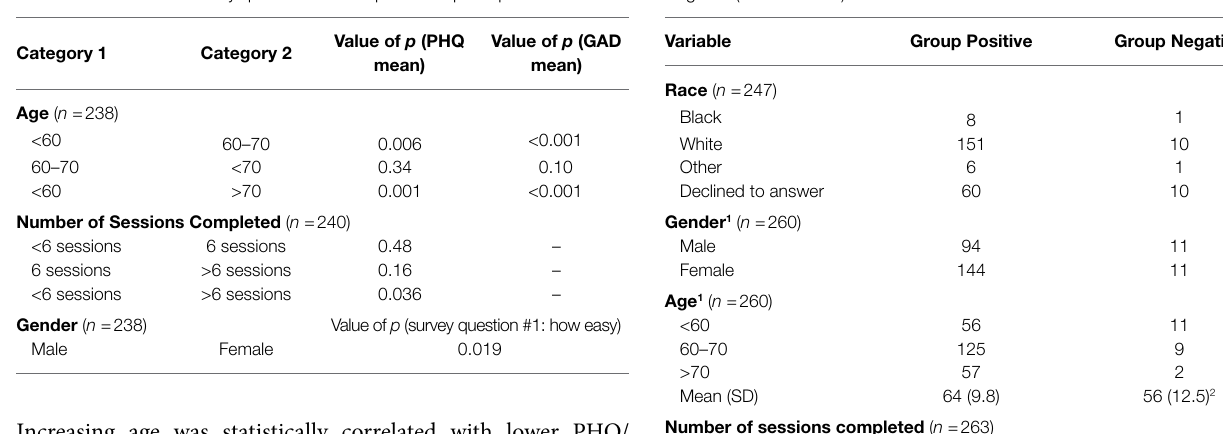
TABLE 5 | Demographic characteristics of Desert Oasis Healthcare study participants for Group Positive (those with a history of depression) and Group Negative (those without).